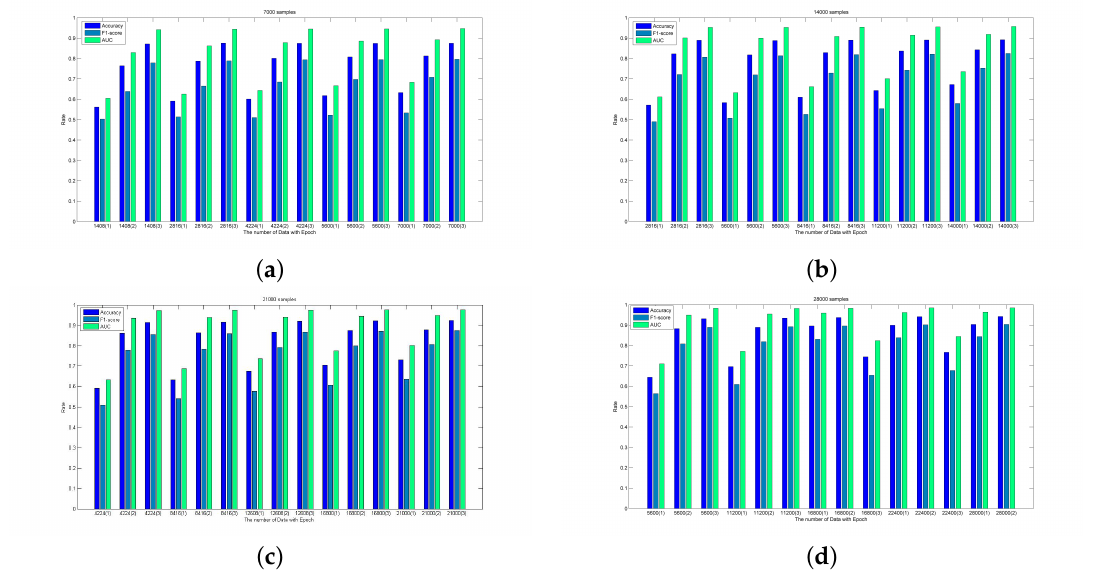
Figure 8. Results of the model when Epoch = 3 (Chinese dataset). ( a ) data samples = 7000. ( b ) data samples = 14,000. ( c ) data samples = 21,000. ( d ) data samples =